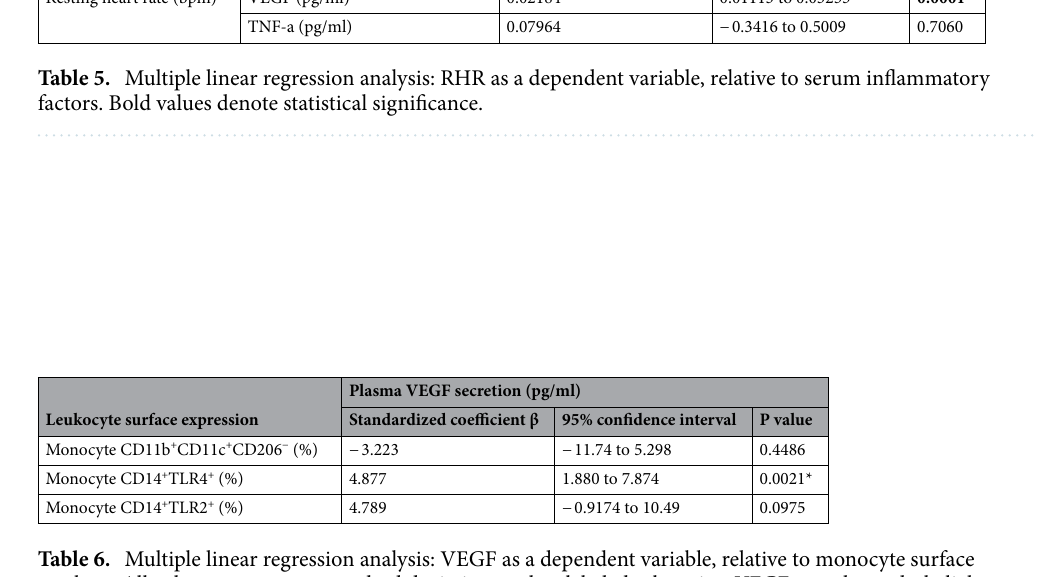
Table 6. Multiple linear regression analysis: VEGF as a dependent variable, relative to monocyte surface markers. All values are means ± standard deviations unless labeled otherwise. VEGF vascular endothelial growth